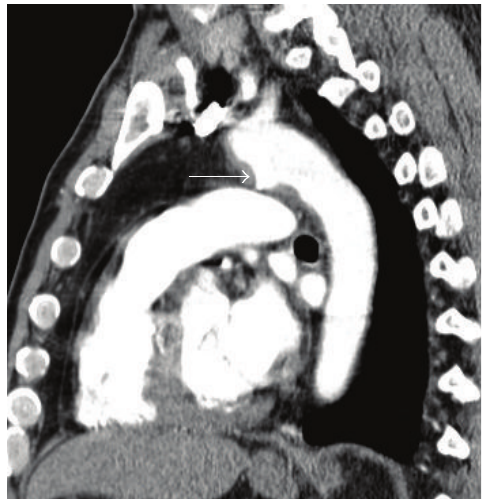
Figure 6: Thoracic aortic pseudoaneurysm in the context of blunt chest trauma. Sagittal reconstruction of arterial phase MDCT demonstrates an abnormal contour of the thoracic aorta. A saccu- lation filled with iodinated contrast material involving the anterior aspect of transition of the aortic arch with the descending aorta, immediately after the emergency of the left subclavian artery, consistent with aortic pseudoaneurysm